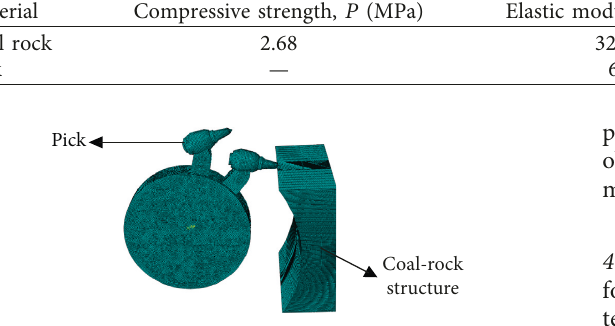
Figure 3: A schematic of the coal-rock structure